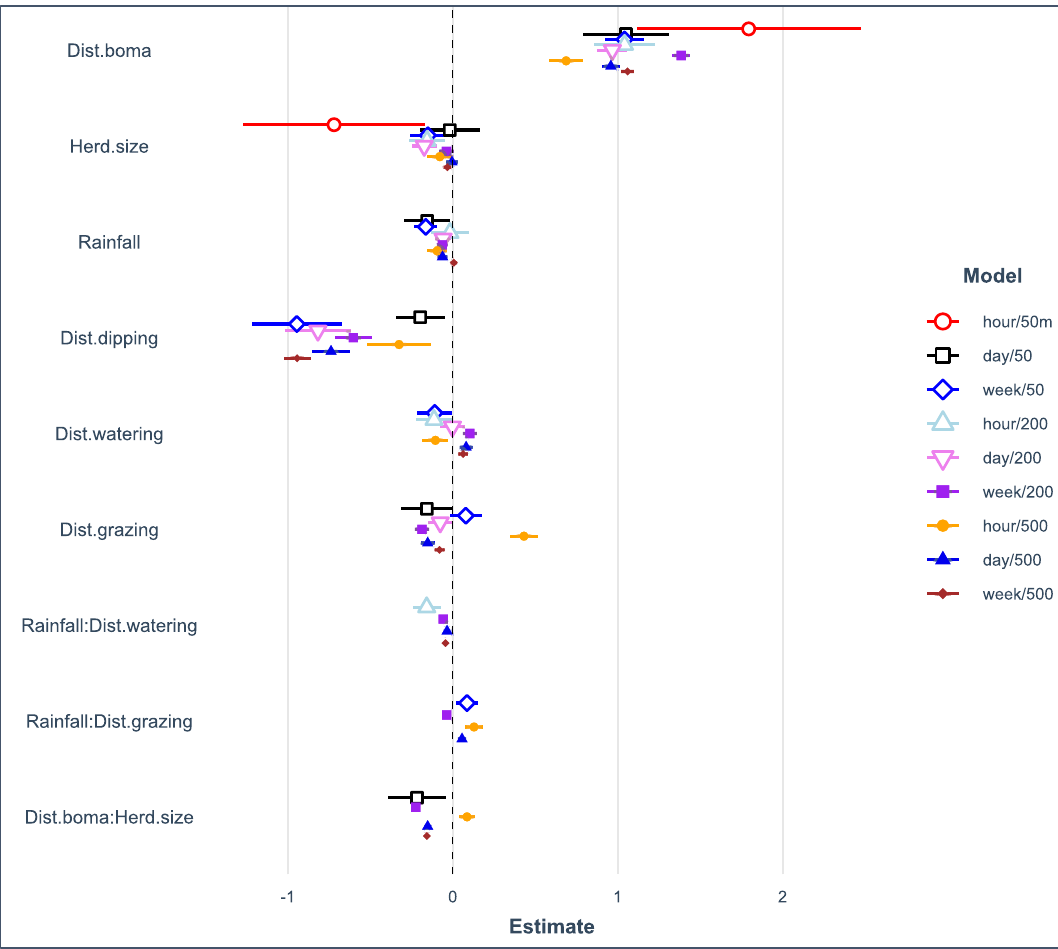
Figure 5. Factors affecting the relative probability of contact in cattle change in their effect sizes across a range of spatiotemporal scales. Variables tested in each model are indicated on the Y-axis, with symbols denoting the mean effect size (lines denote 95% C.I.) of variables retained in the top candidate model at each spatiotemporal scale of